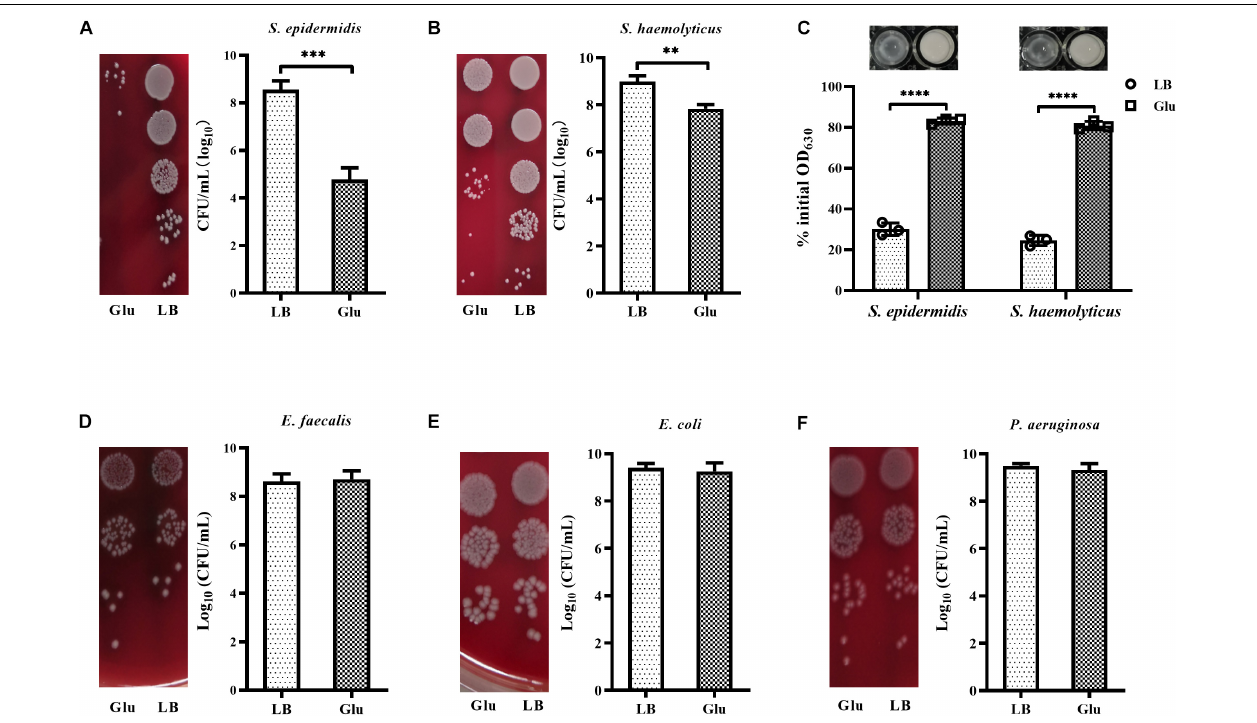
FIGURE 6 | Glucose reduced the growth of staphylococci. (A) S. epidermidis RP62A and (B) S. haemolyticus SH01 were cultured in LB medium with or without 25 mM glucose for 48 h, then the CFUs of the cultures were determined by serial dilution and plating on BA. (C) S. epidermidis RP62A and S. haemolyticus SH01 were cultured in LB medium with or without 25 mM glucose for 24 h. The bacterial cells were collected by centrifugation, resuspended in PBS buffer, and lysostaphin was added at a final concentration of 10 µ g/mL. OD 630 measurements were recorded after 30 min. (D) Enterococcus faecalis ATCC29212, (E) Escherichia coli ATCC25922, and (F) P. aeruginosa ATCC27853 were cultured in LB medium with or without 25 mM glucose for 48 h, then CFUs of the cultures were determined by serial dilution and plating on BA. ∗∗ p < 0.01; ∗∗∗ p < 0.001; ∗∗∗∗ p <